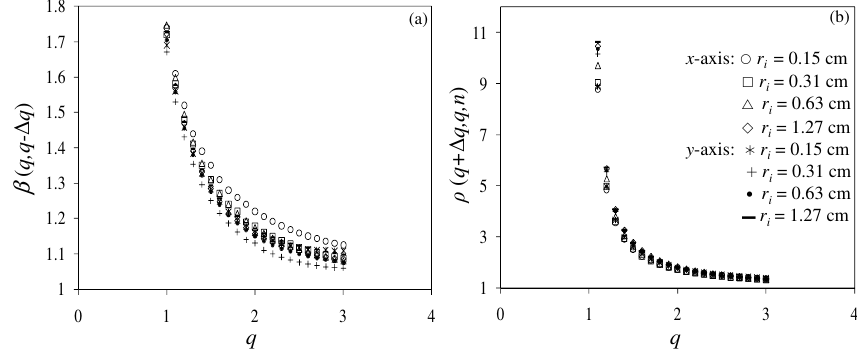
Fig. 13. (a) β(q , q − 1q) and (b) ρ(q + 1q , q , n =0.5) versus q evaluated using all available data in x and y directions and various r i